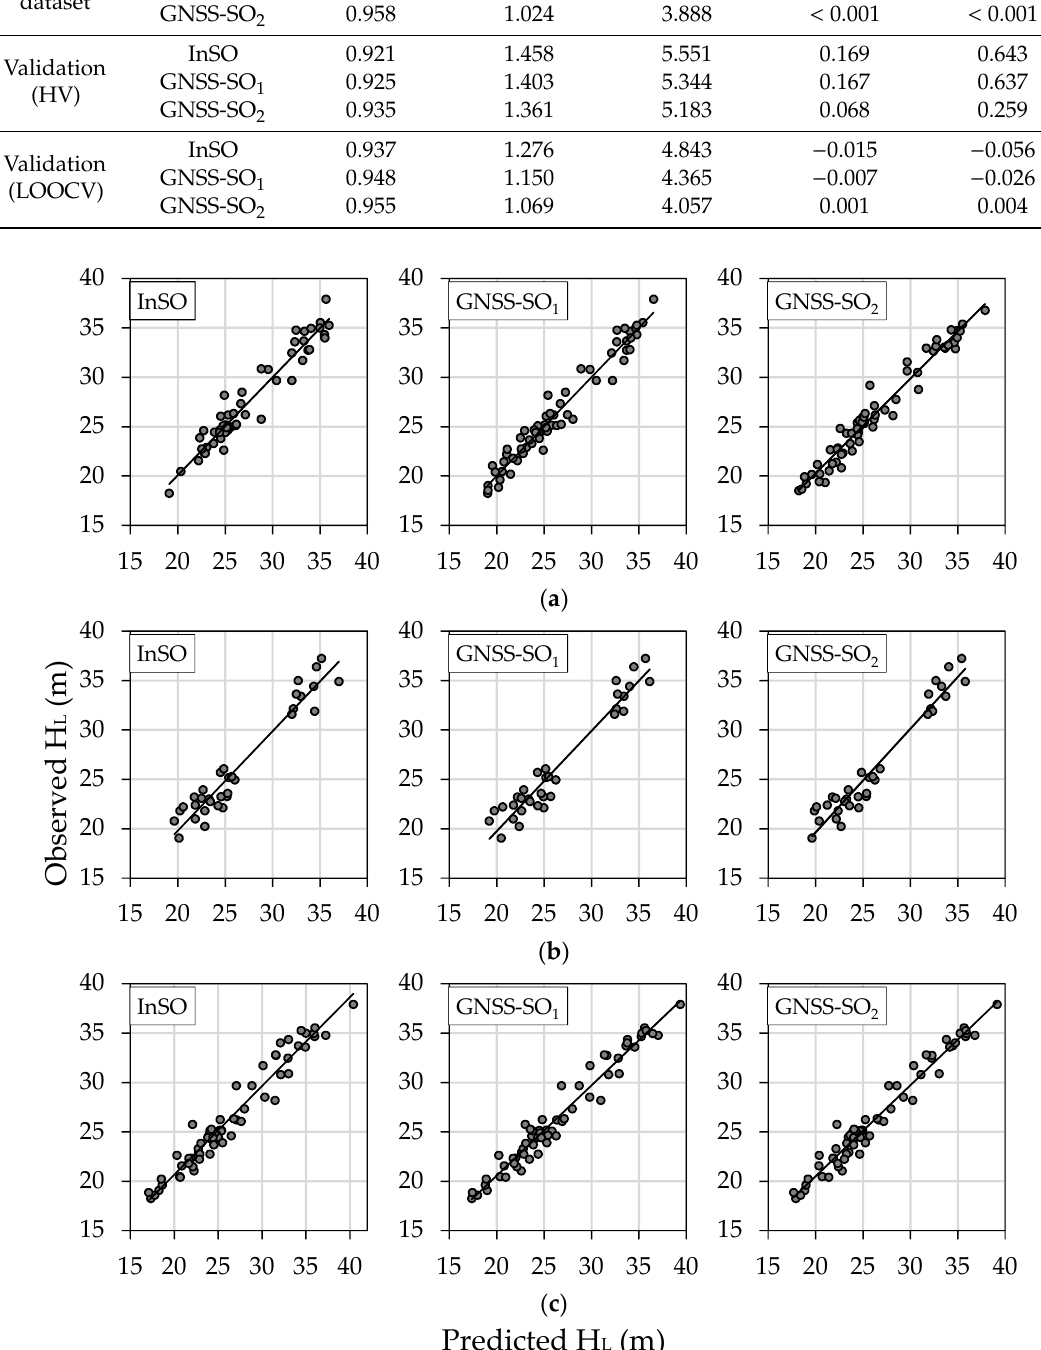
Figure 5. Observed vs. predicted plot-level Lorey’s mean height (H L ) for selected models (Table 5): ( a ) modeling dataset; ( b ) hold-out validation (HV), i.e., field validation across independent sample plots; ( c ) the leave-one-out cross-validation